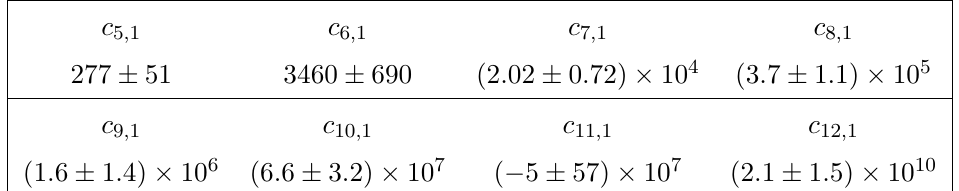
Table 6. Final values for the QCD Adler function coe(cid:14)cients obtained from PAs to (cid:14) (0)